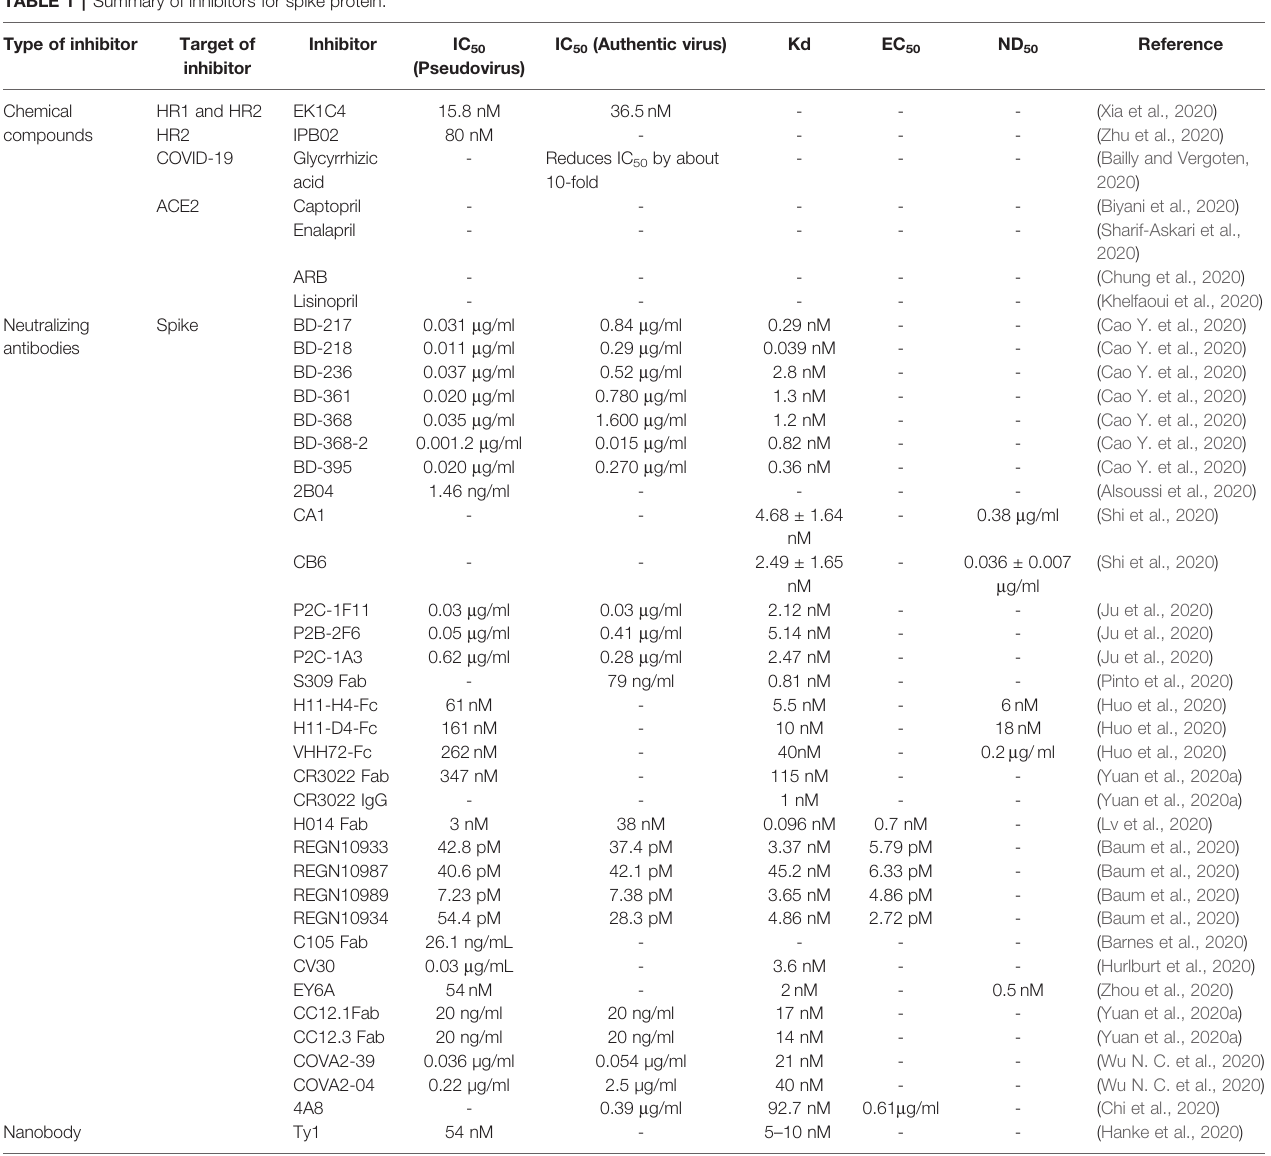
TABLE 1 | Summary of inhibitors for spike protein. Type of inhibitor Target of